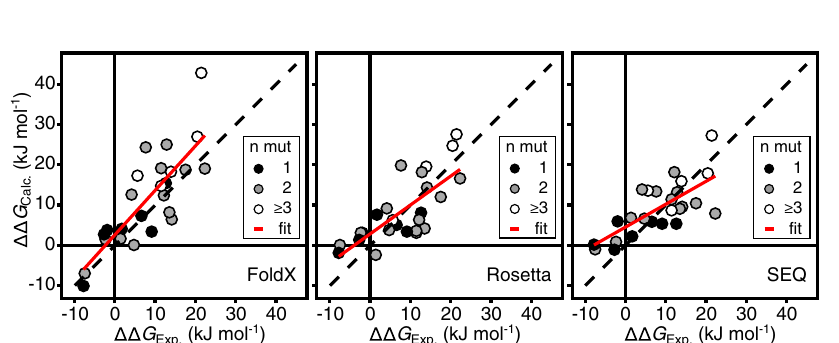
Fig. 2 Correlations between experimentally determined and predicted ΔΔ G f values. The predicted values were calculated by FoldX, Rosetta and SEQ as indicated in the lower right part of each panel. The dotted line shows the identity line and the solid red line is the best fi t straight line. Each data point represents one of the variants in Table 1 and the data points are coloured according to the number of amino acid substitutions (black — one substitution; grey — two substitutions; white — three or more substitutions). The scale for the SEQ method is in arbitrary